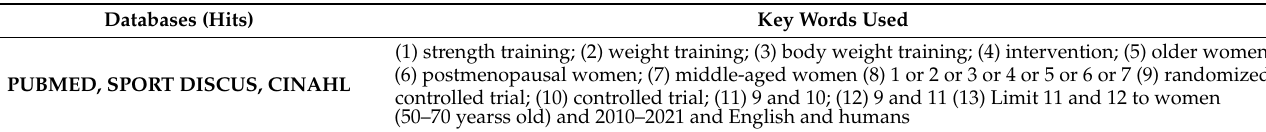
Table 1. Sample search string used for this study.